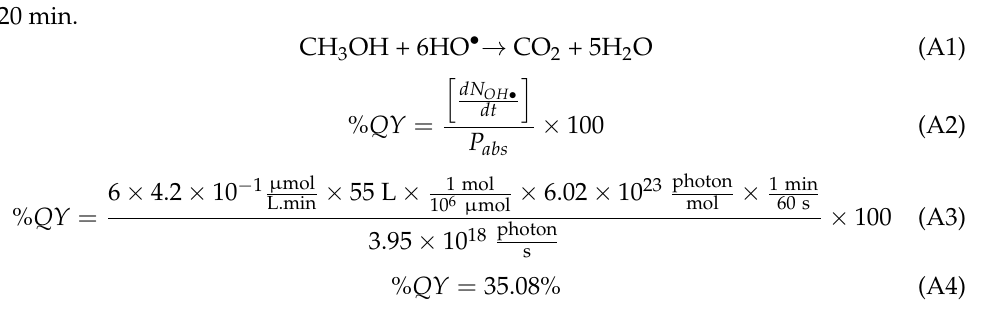
Figure A2. Calibration curve and operational range (pink band) representing relative humidity (RH%) for all measurements developed in Photo-CREC-Air Reactor at 39 ± 0.5 °C.